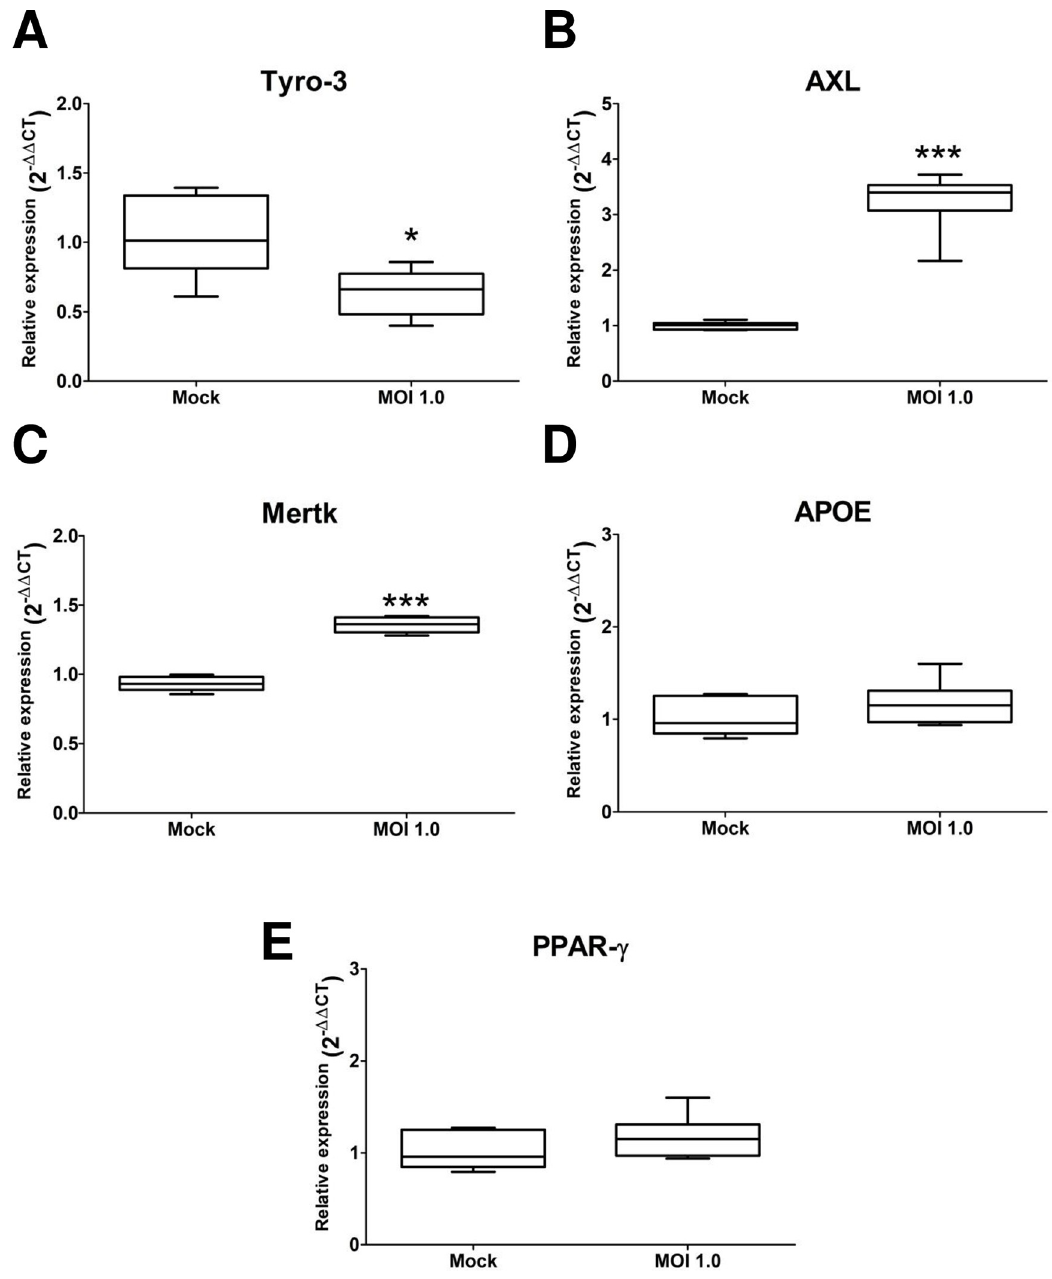
Fig 5. ZIKV infection can modify genes of the TAM family and genes involved in the lipidic metabolism. The astrocytes-hNS1 culture was infected with either ZIKV (MOI of1) or mock-infected. At five dpi, the cellular RNA was recovered and the relative expression of the mRNAs for the receptors of the TAM family (Tyro-3, AXL, and Mertk), and APOE and PPAR γ mRNAs associated with lipid metabolism were determined by qRT-PCR. (A) Tyro-3 relative expression, p = 0.025, n = 6, t-test. (B) Relative expression of AXL, p = 0.0022, n = 6, U Mann Whitney test. (C) Relative expression of Mertk, p = 0.0006, n = 6, t-test. (D) Relative expression of PPAR- γ , p = 0.24, n = 6, t-test. (E) APOE relative expression p = 0.18, n = 6, t-test. The data correspond to the mean and standard